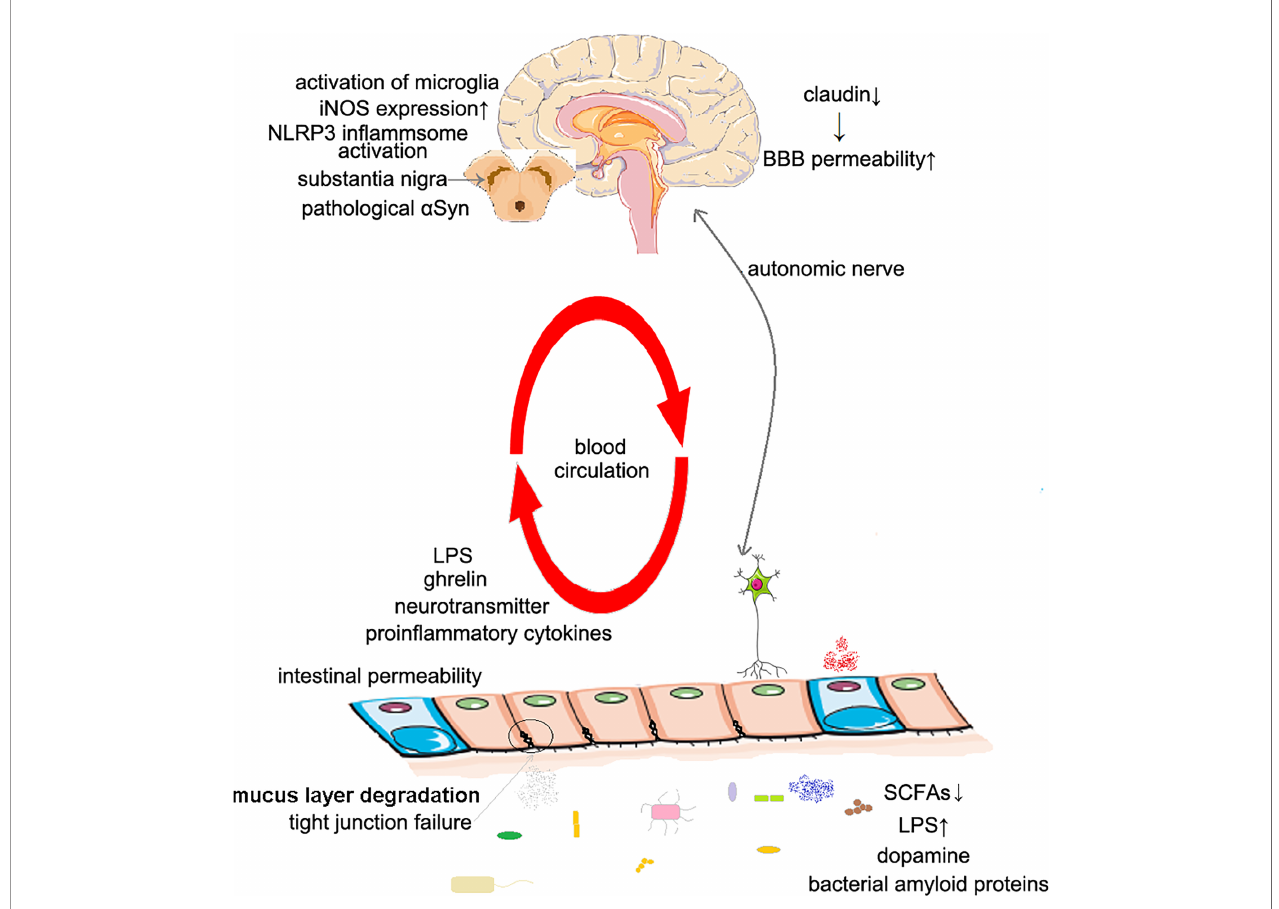
FIGURE 1 | The possible mechanisms of Parkinson ’ s disease caused by intestinal dysbiosis. The increased intestinal permeability: The decrease of SCFAs concentration in intestinal cavity leads to local in fl ammation, and also affects the expression of tight junction proteins, including claudin 1 and claudin 2. The increased BBB permeability: Intestinal dysbiosis leads to decreased claudin expression. In fl ammation and oxidative stress: The decrease of SCFAs concentration leads to the dysfunction of microglia; the increase of LPS concentration activates microglia, NLRP3 in fl ammasome and promotes the expression of iNOS. Changes of the production of dopamine: Dysbiosis changes the level of dopamine produced in the gut; the concentration of SCFAs affects the secretion of ghrelin, thus affecting the secretion of dopamine in substantia nigra. Molecular mimicry: Bacterial amyloids may induce immune response to a Syn in human body. SCFAs, short- chain fatty acids; BBB, blood – brain – barrier; LPS, lipopolysaccharide; iNOS, inducible NO